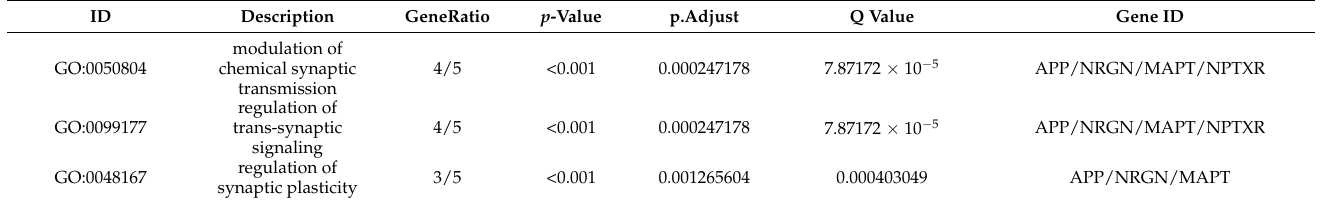
Table 1. GO enrichment analysis for biological processes in terms of genes related to tested proteins in